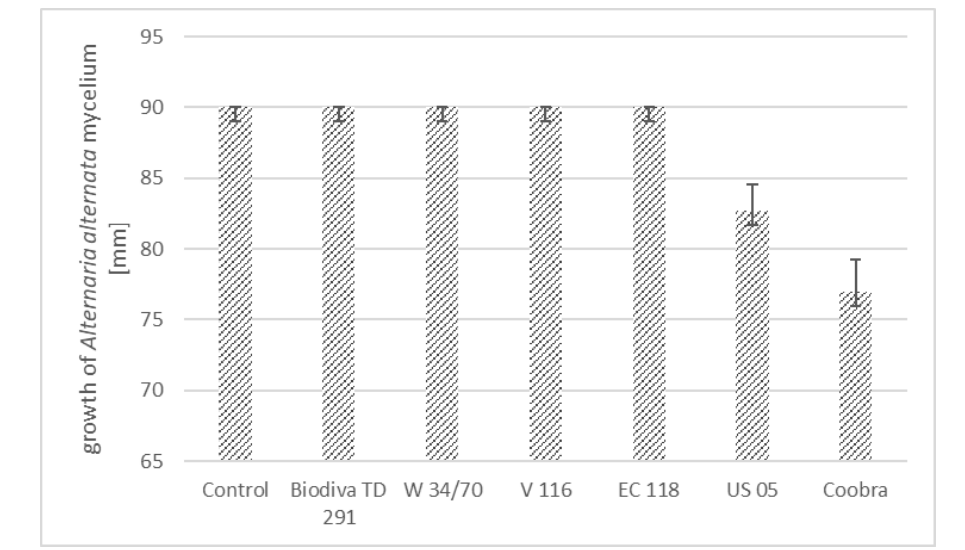
Figure 3. Inhibitory effect of antagonistic yeast strains on the growth of Alternaria alternata mycelium after six days. Mycelium diameter in the cultures (mm) on Petri plates ± SD. Table 3. Inhibitory effect of antagonistic yeast strains on the growth of Alternaria alternata mycelium three days after moving the fungal disc to the fresh medium.